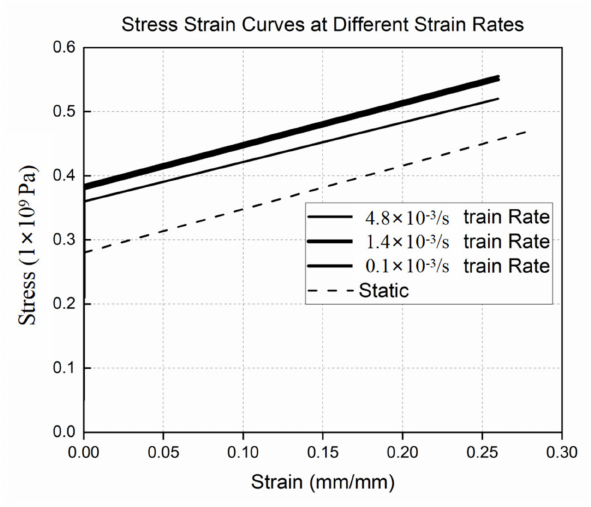
Figure 4. Stress–strain curve of ASTMA-106B